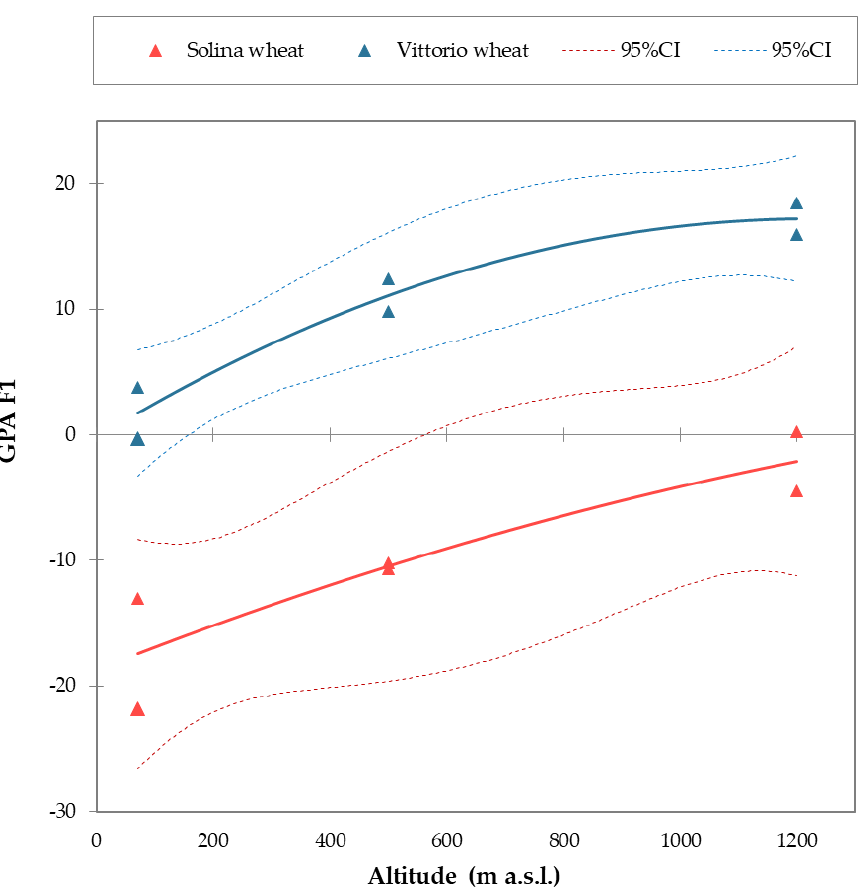
Figure 5. Non-linear regression (second order polynomial equation) of centroid coordinates computed by GPA along altitude. CI: Confidence intervals.